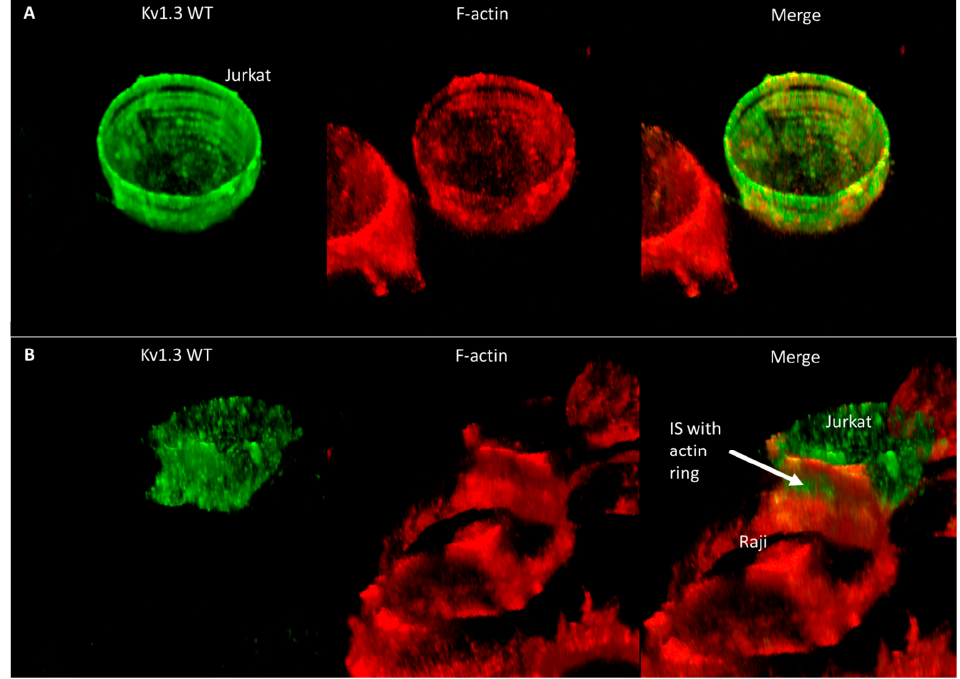
Figure 6. Distribution of Kv1.3 WT and F-actin in standalone and IS-engaged Jurkat cells. Kv1.3 was tagged with mGFP and F-actin was labeled with Alexa546-phalloidin. 3D reconstructions from z-stacks of confocal images are shown. ( A ) Standalone cells, ( B ) Jurkat cell in IS with Raji cell. The arrow marks the IS and the F-actin ring formed at its periphery.